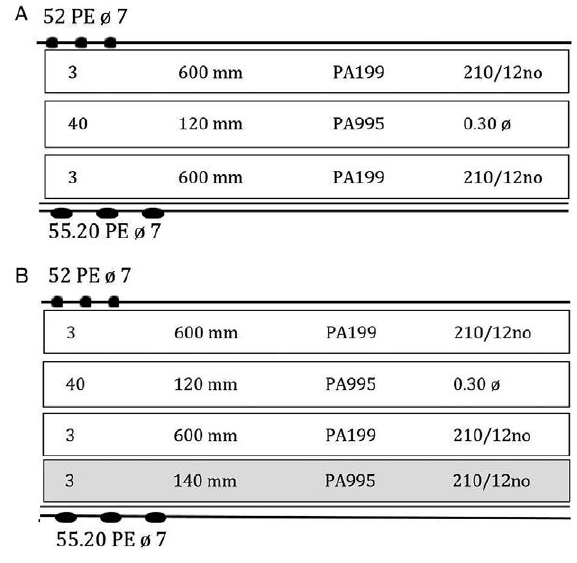
Fig. 1. – Technical plans for the standard trammel net (A) and the modified trammel net rigged with a guarding net (B). PA, polyam- ide; PE,